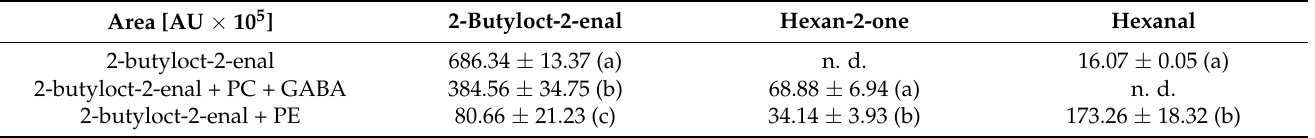
Table 6. Peak areas of 2-butyloct-2-enal, hexan-2-one, and hexanal from 2-butyloct-2-enal (0.05% in paraffin oil) without or with GABA + PC or PE, heated at 160 ◦ C for 20 min and analyzed by HS-GC-MS; n. d. = not detected. Area [AU × 10 5 ]